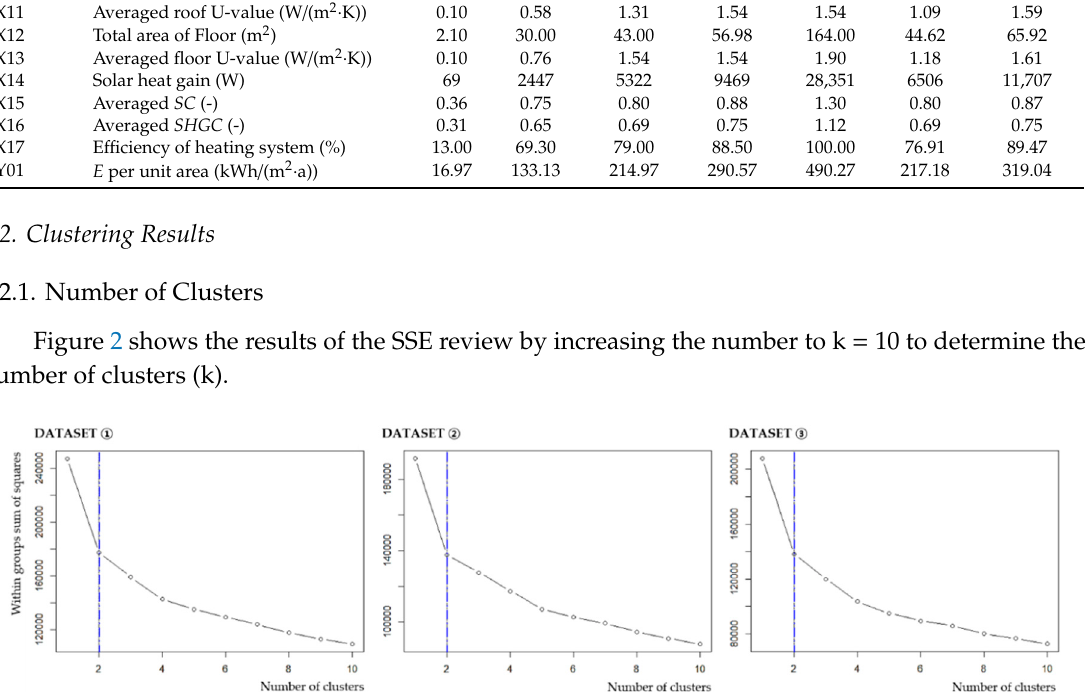
Table 4. Standard model derived through methods 1 and 2.